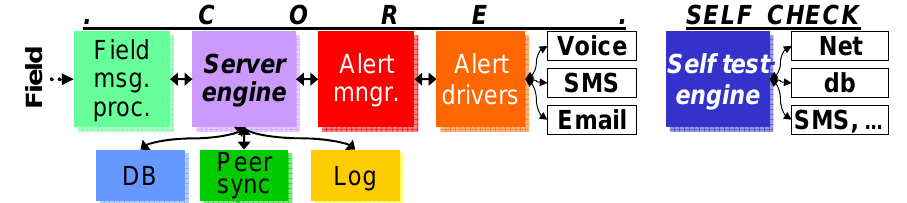
Figure 10. The application server structure is split into core services and a self-test